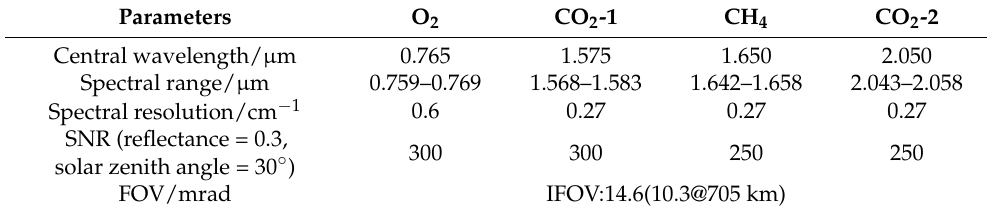
Figure 2. The GMI’s workflow. Table 1. Main performance index of the GMI.